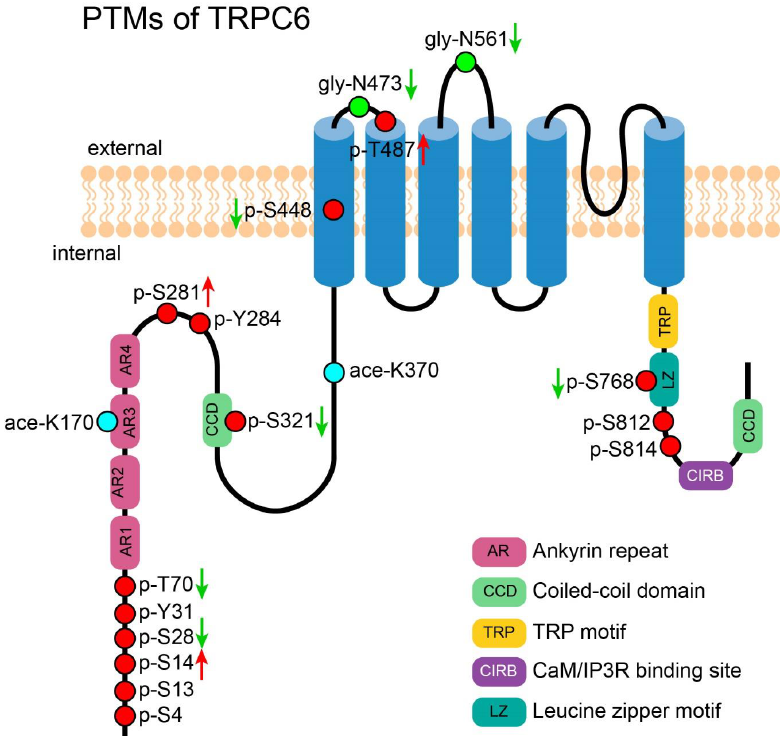
Figure 5. PTMs of TRPC6. A cartoon depicting TRPC6 with its important motifs and PTMs (those exact positions had been reported). PTMs are presented in circles. Red circles represent the reported phosphorylation sites of TRPC6, which are labeled in the format of a “p-amino acid-position”. Green circles represent the reported N-glycosylation sites, which are labeled in the format of a “gly-amino acid-position”. Cyan circles represent the reported acetylation sites, which are labeled in the format of a “ace-amino acid-position”. The green arrows near the labels denote the PTMs which decrease the channel’s activity. The red arrows near the labels denote the PTMs which increase the channel’s